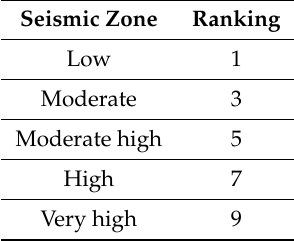
Table 4. ‘Seismic zone’ rankings considered in Multi-Criteria Decision Making (MCDM) methods.